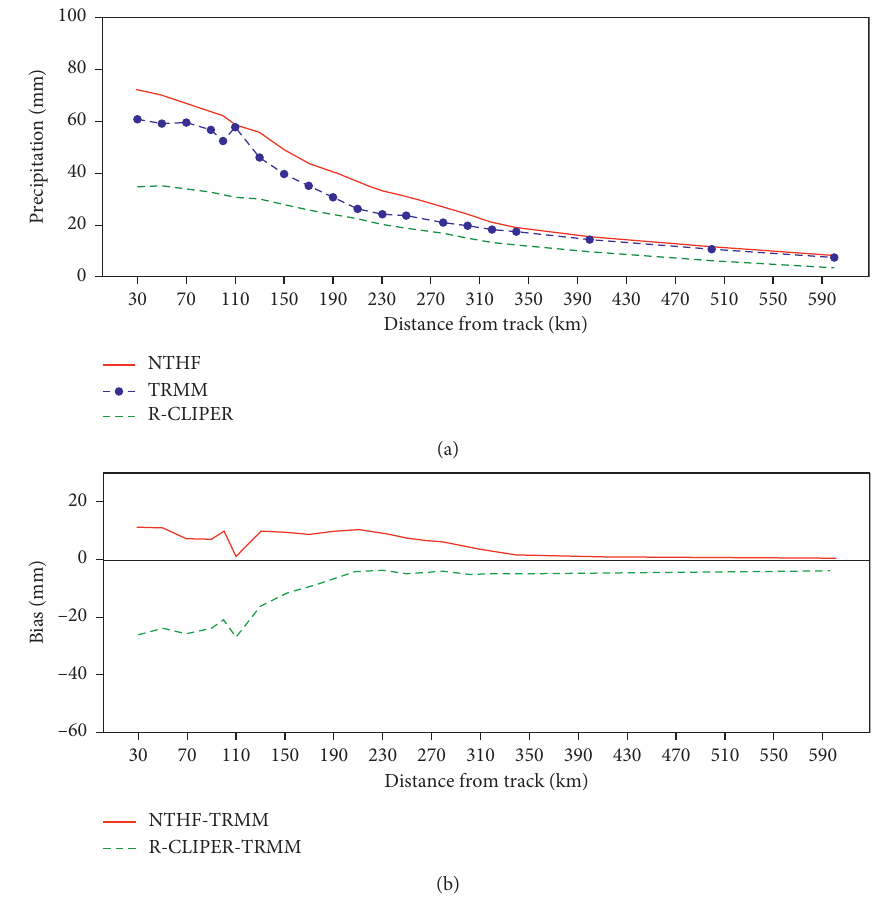
Figure 7: Mean rainfall radial distribution at 24h. (a) Values determined from TRMM and calculated by NTHF and R-CLIPER. (b) Bias between system predictions and TRMM